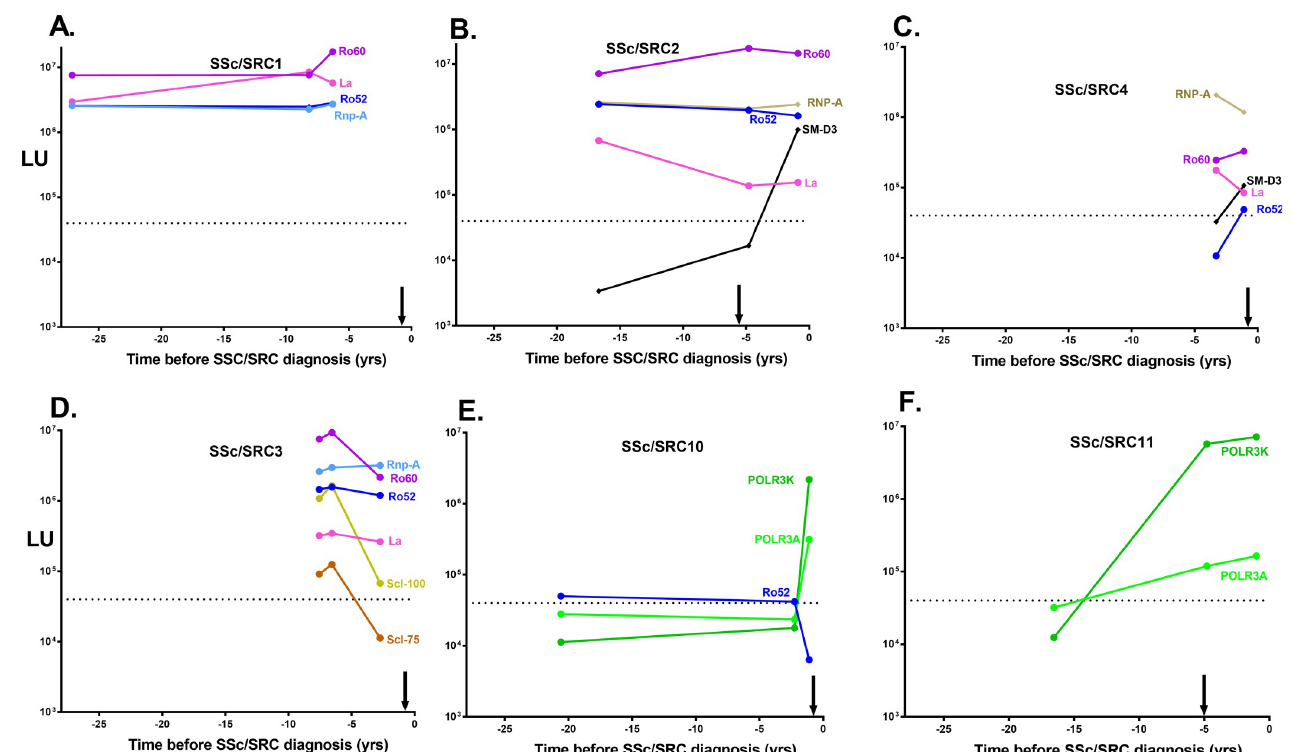
Fig 4. Representative autoantibody profiles seen in SSc/SRC cases before disease diagnosis. Representative plots illustrating autoantibody levels in six SSc/ SRC subjects before disease diagnosis. The X-axis denotes the time in years before diagnosis of SSc/SRC (time 0). The approximate time of SSc/no SRC diagnosis preceded SSc/SRC and is denoted by the black vertical arrow. The left Y axis represents the autoantibody levels in LU and the dotted line represent the approximate cut-off value for the autoantigens.